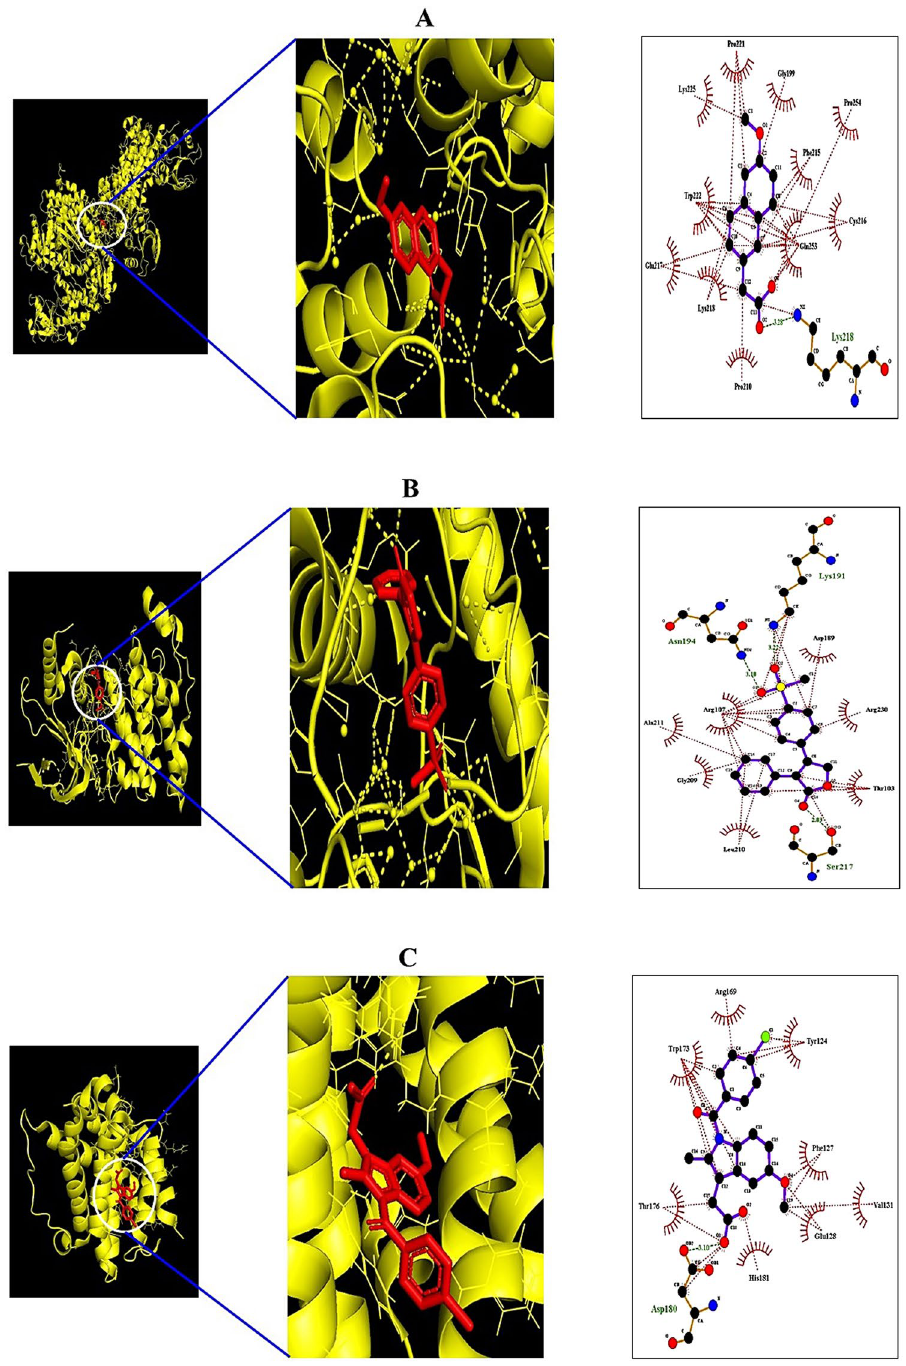
Figure 7. Molecular docking interaction between best docked NSAIDs and target proteins. ( A ) 6MNA on MAPK 8 (PDB ID:4YR8) ( B ) Rofecoxib on MAPK 10 (PDB ID:3TTJ). ( C ) Indomethacin on BAD (PDB ID: